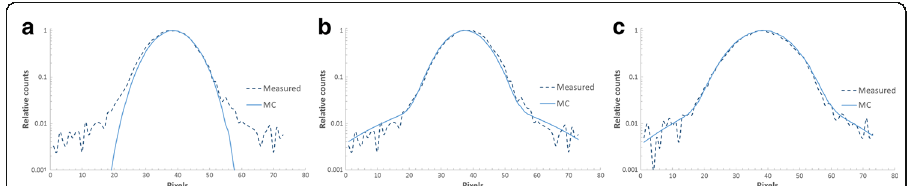
Fig. 2 MC simulation of a gamma camera image of 177 Lu line sources revealed similar profiles as the measured line profiles. a The simulated line profiles when using an ARF without scattering kernel, 5 cm from the collimator surface (observe the logarithmic scale). b . c The simulated line profiles when using an ARF with a scattering kernel, 5 and 10 cm, respectively, from the collimator surface